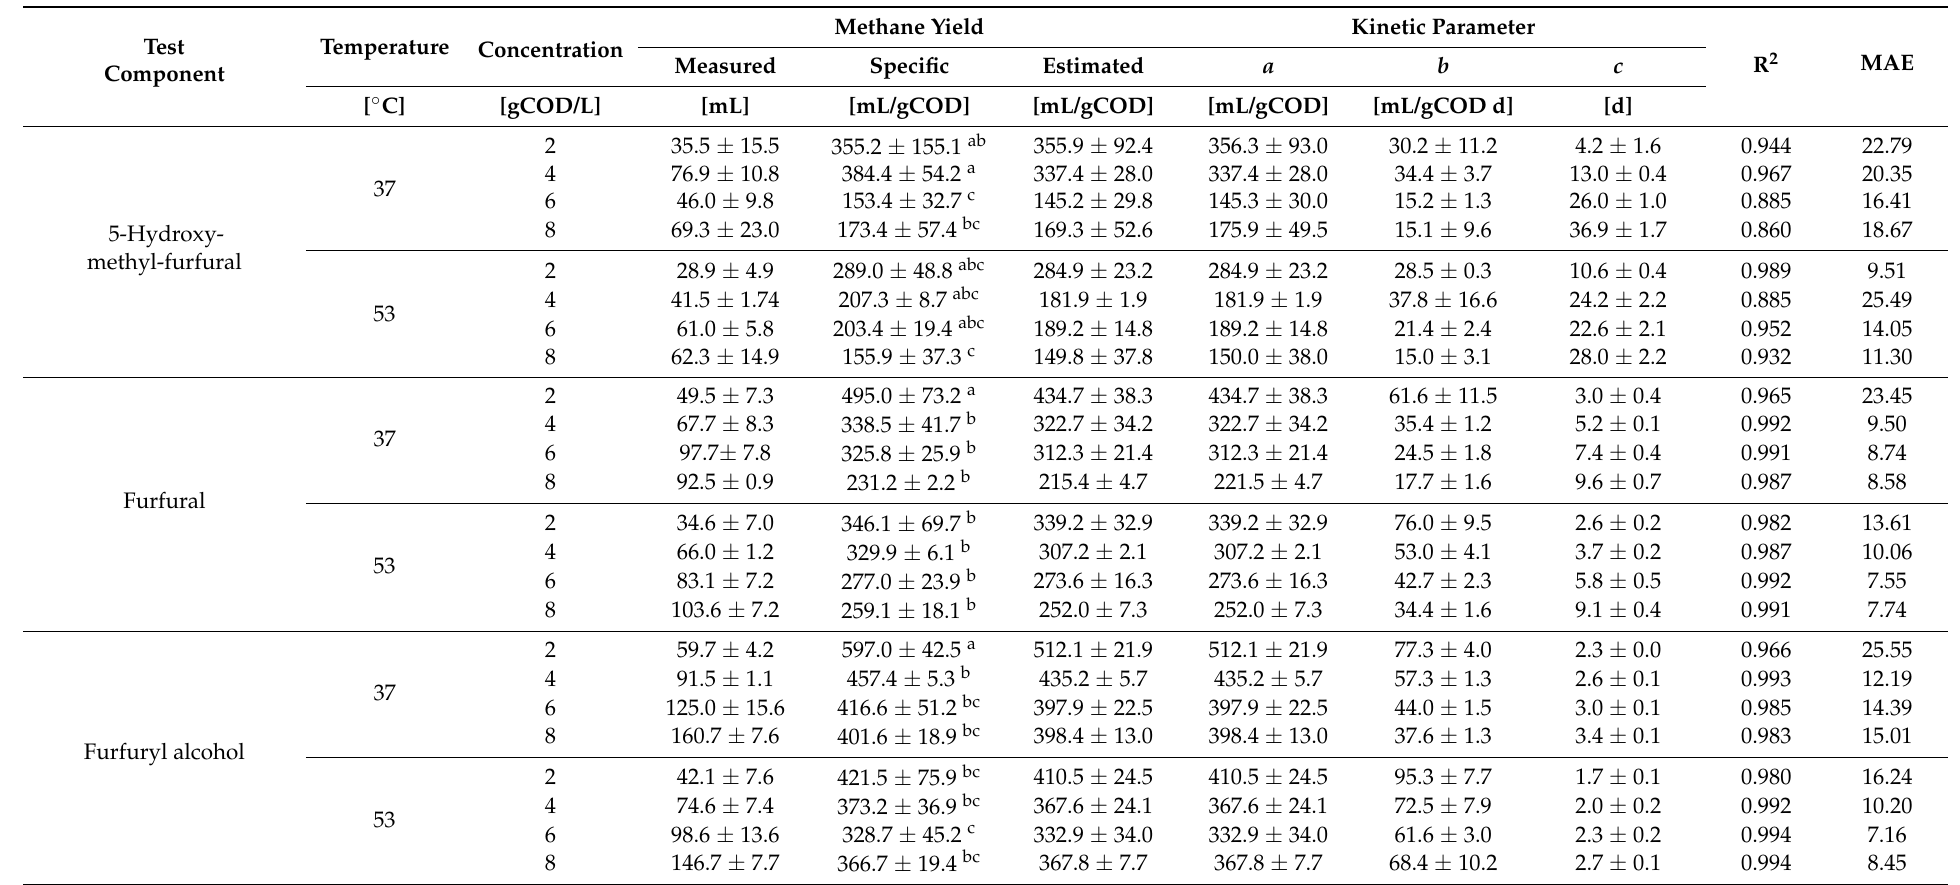
Table 5. Mean methane yields for the given concentrations of the furanic compounds under mesophilic and thermophilic conditions with kinetic parameters ( a : max. methane produced, b : max. methane production rate, and c : lag phase) from the modified Gompertz